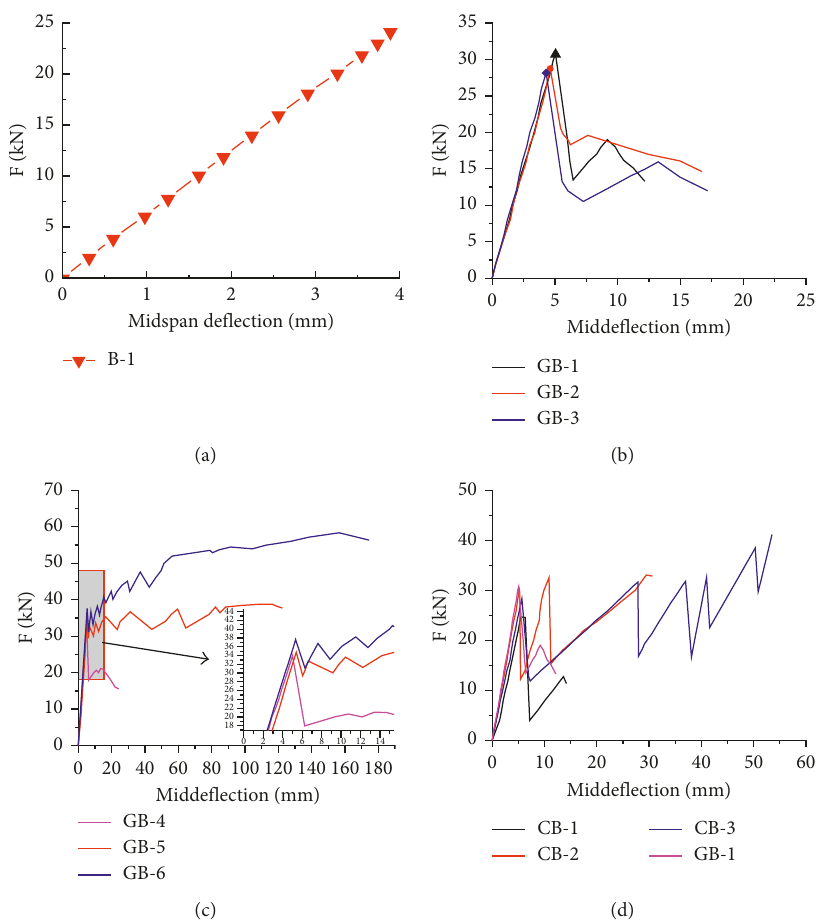
Figure 34: Midspan deflection curves: (a) B-1; (b) GB-1 ∼ 4; (c) GB-4 ∼ 6; (d) CB-1 ∼